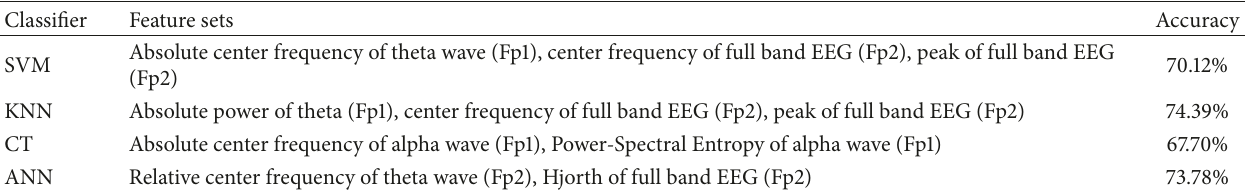
Table 4: Classification results in neutral audio stimulation data.